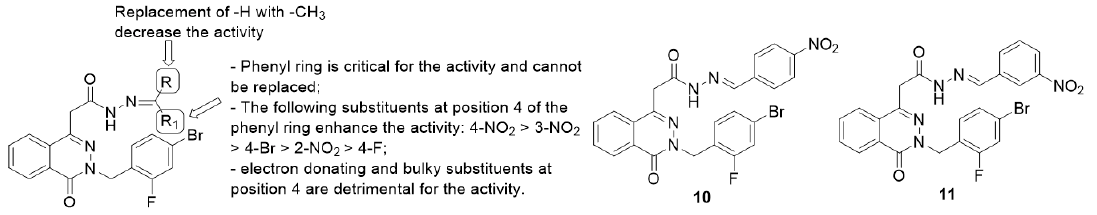
Figure 22. SARs of phthalazinyl hydrazones and chemical structures of compounds 10 and 11.